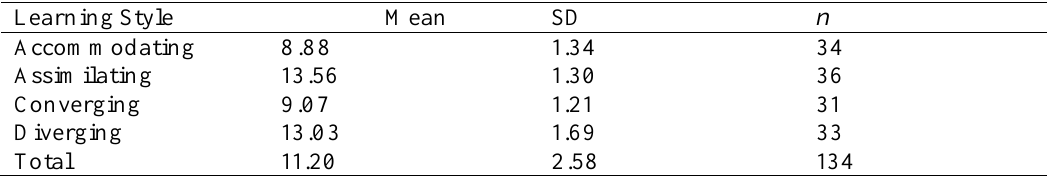
Students’ Self-Efficacy toward Learning in Mobile Facebook